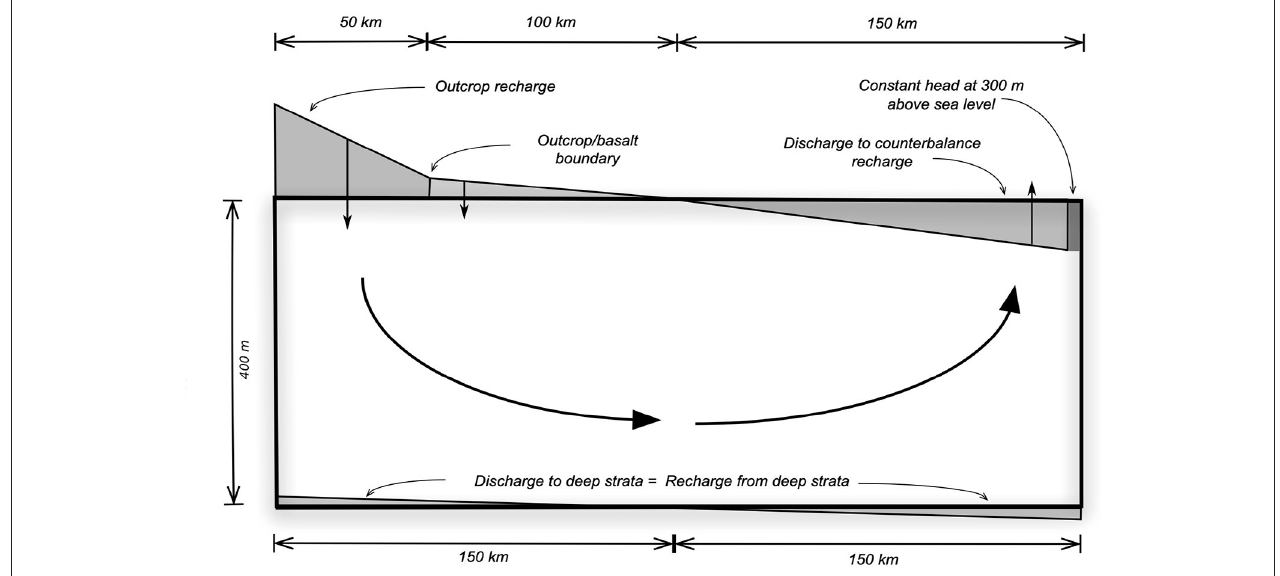
FIGURE 1 | Conceptual 2D model of the water flow in the GAS with shaded polygons depicting water fluxes through the top and bottom